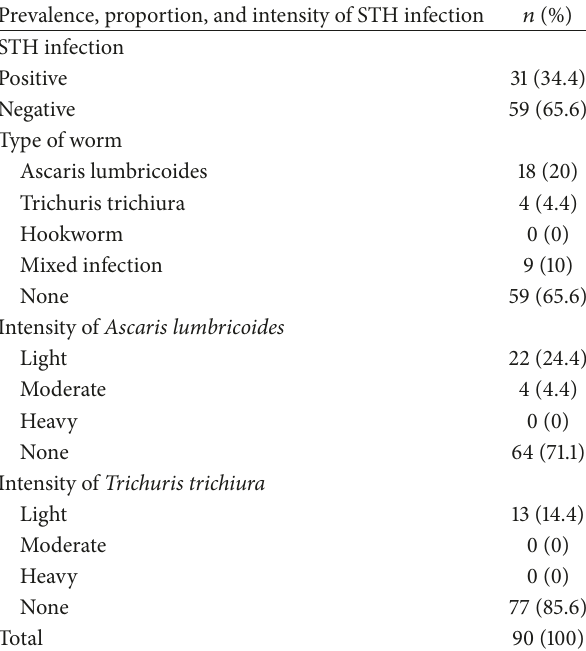
Table 1: Baseline characteristics. Table 2: Prevalence, proportion, and intensity of STH